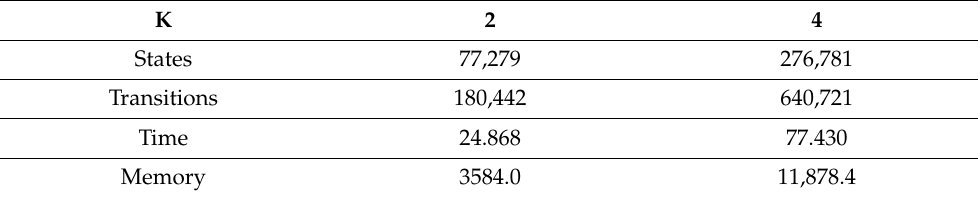
Table 1. Model information of MDP in